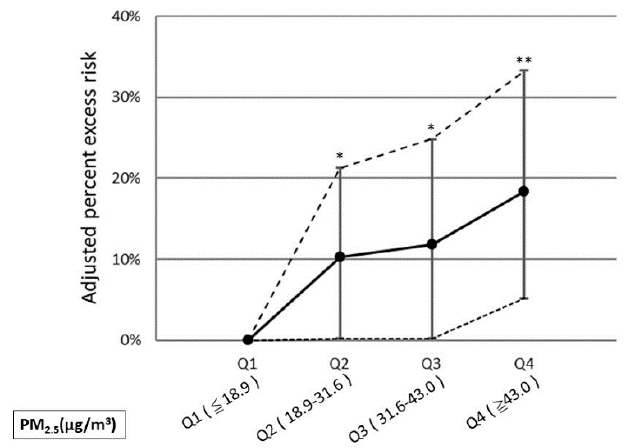
Figure 3. Adjusted risk of COPD according to ambient PM 2.5 levels. The y-axis represents the percentage of excess risk with 95% confidence intervals. * p < 0.05, ** p < 0.01.